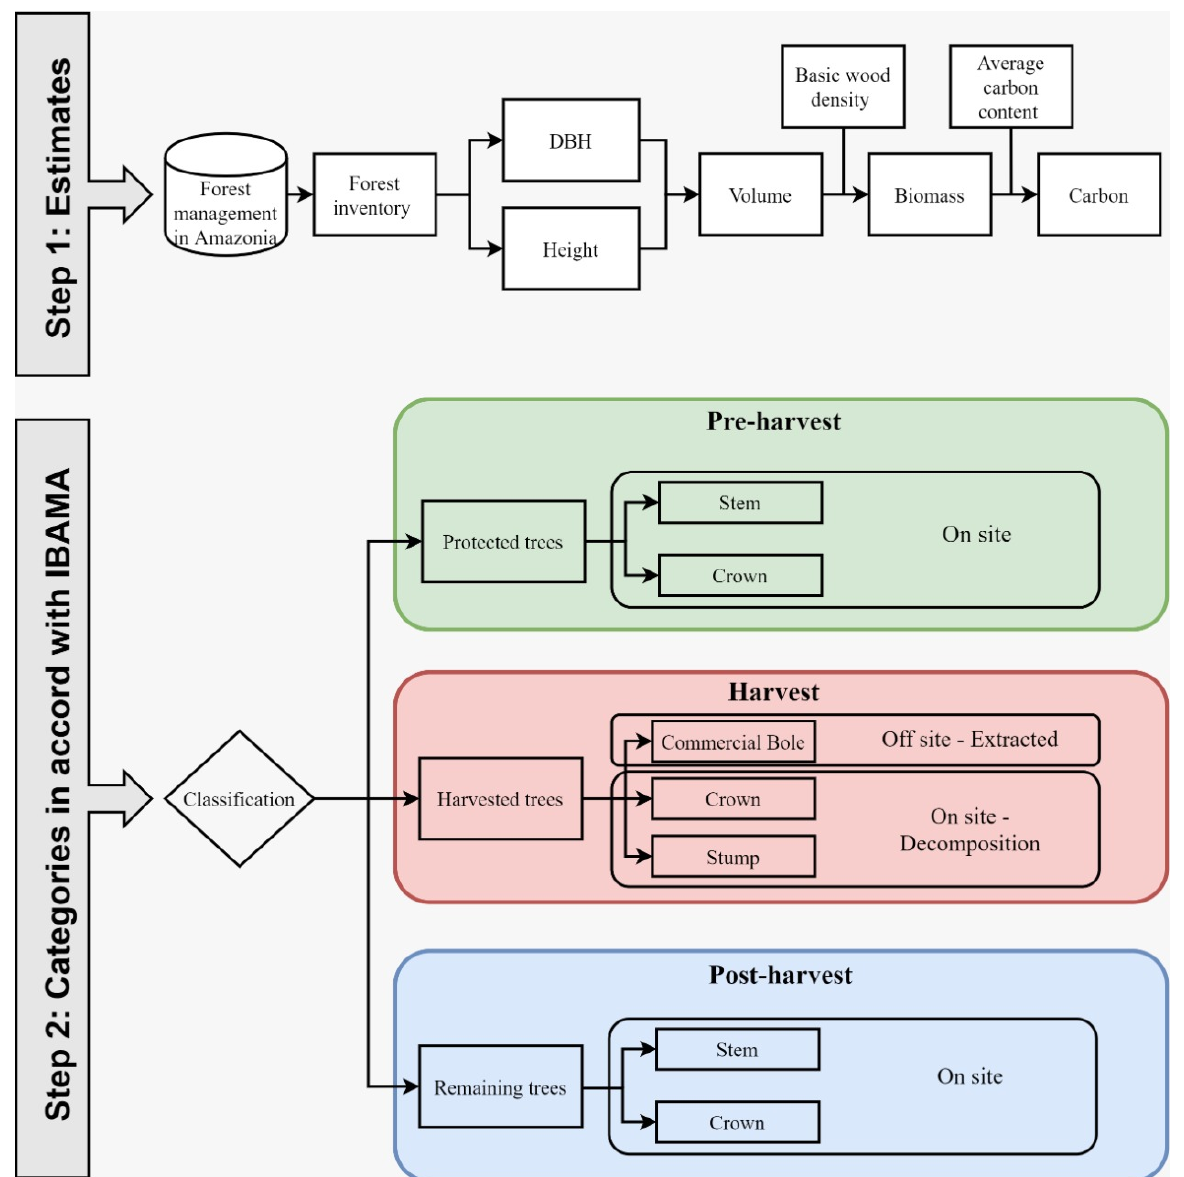
Figure 2. Methodological flowchart with the steps for pre- and post-harvest volume, biomass and carbon of managed forest in Brazil’s state of Acre. Stem = trunk from the ground to the first significant branch. Commercial bole = trunk from the stump cut to the first significant branch. The stumps in this management system are 30 cm in height.